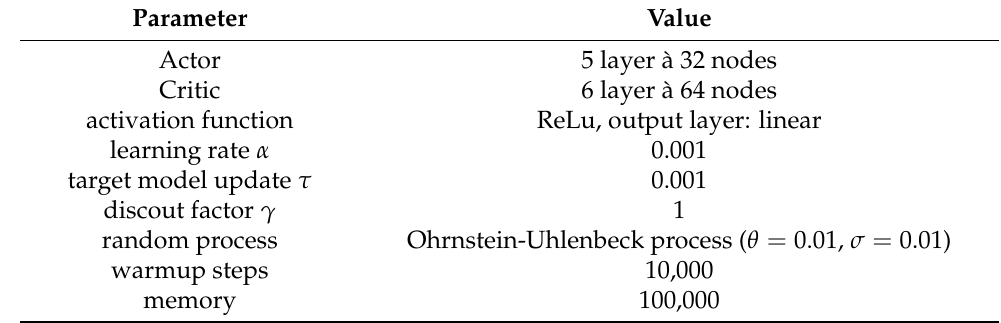
Table 1. Deep reinforcement learning (DRL) agent parameters.